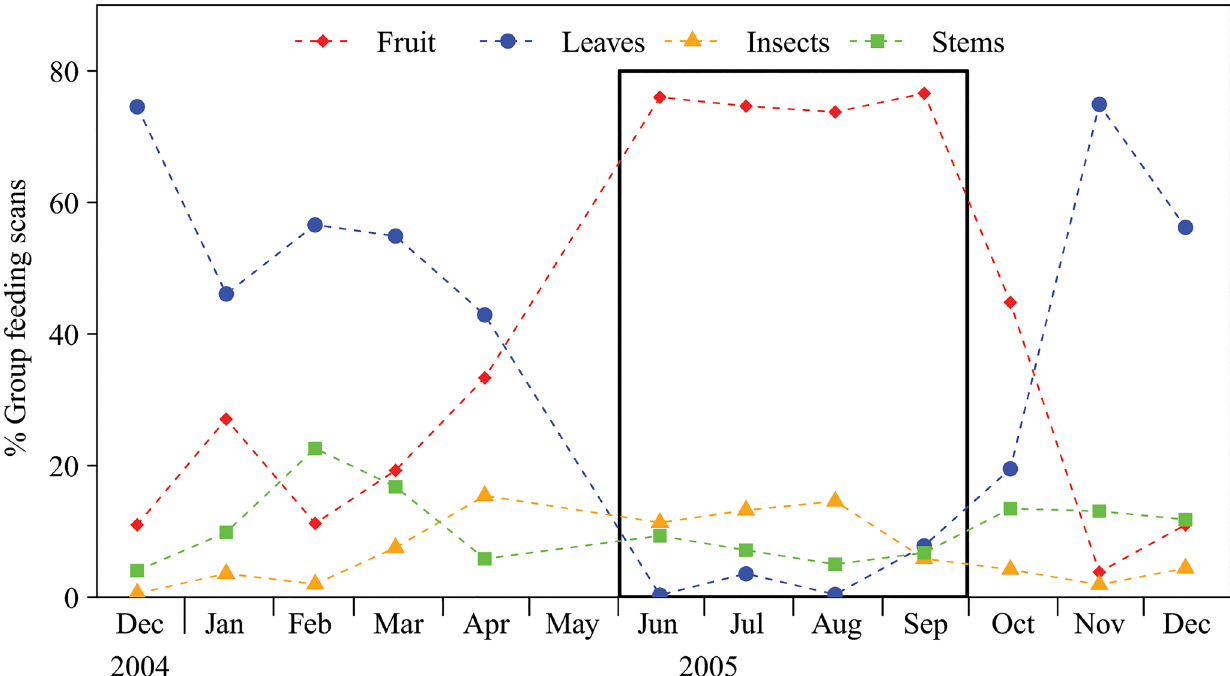
Fig 1. Seasonal variation in gorilla diet according to the time spend feeding on the most important food types (the bold box highlights the high- frugivory